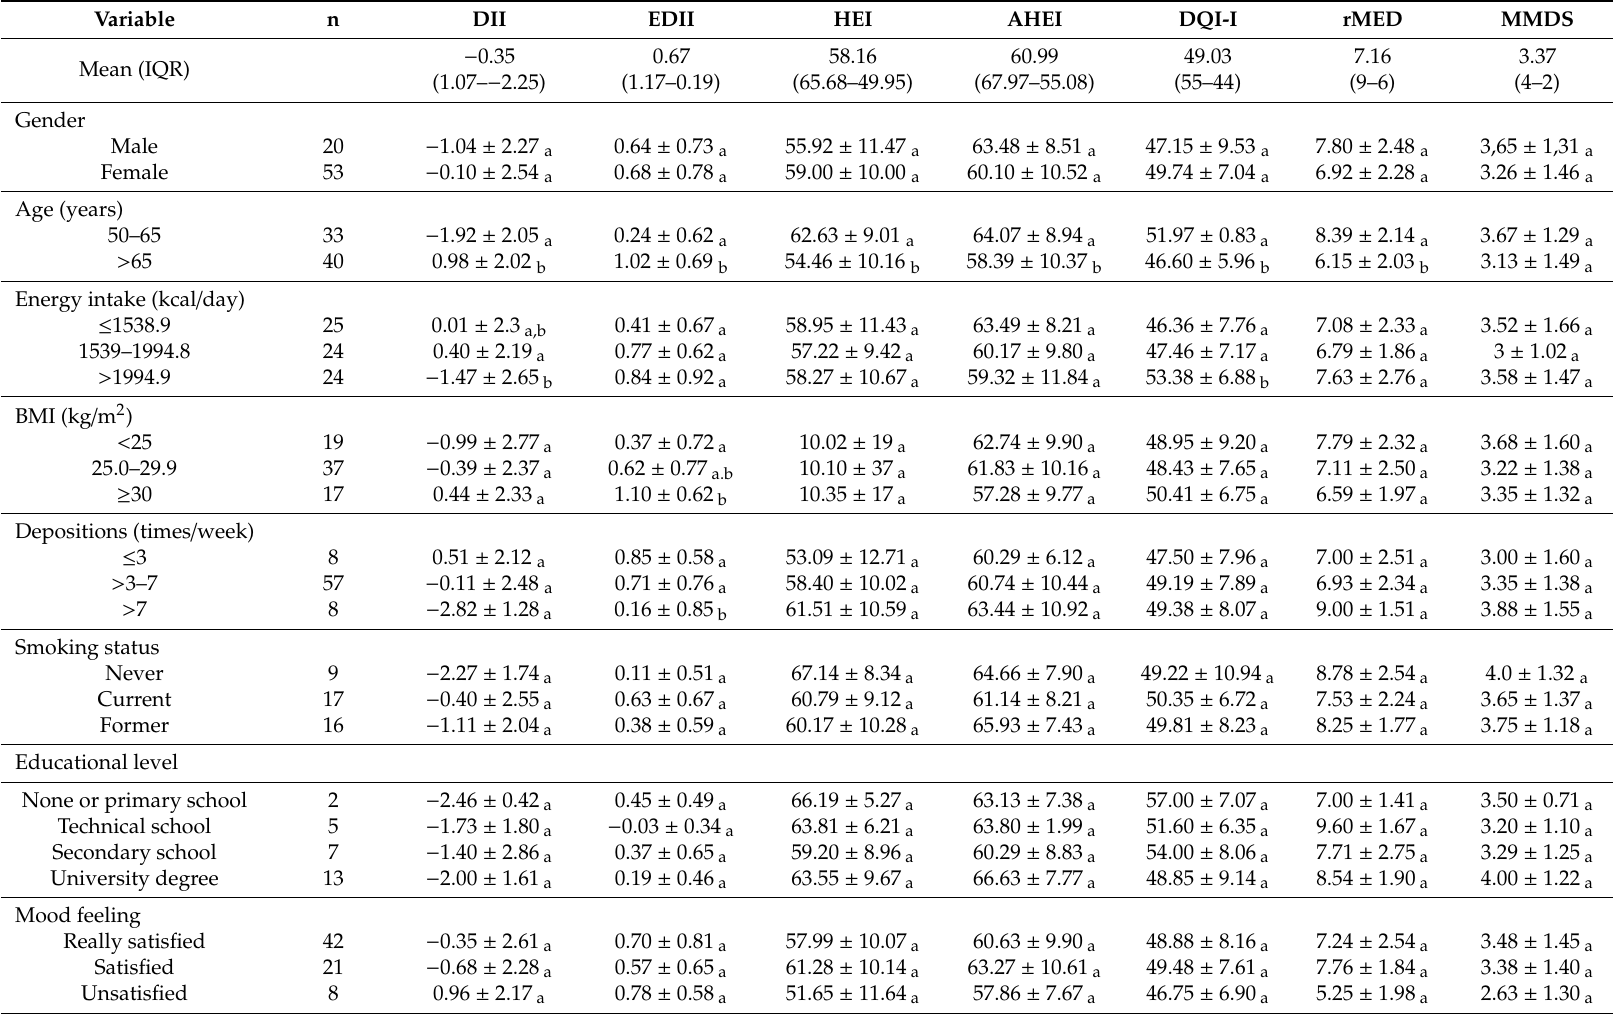
Table 1. Dietary indices score according to di ff erent characteristics of the